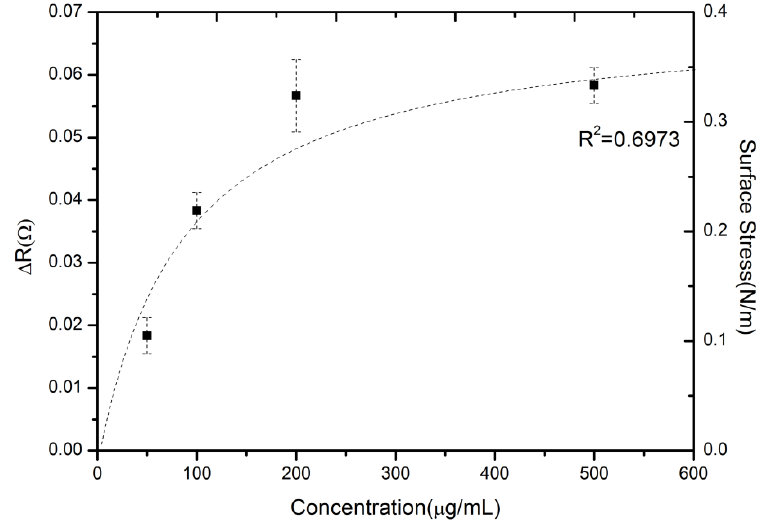
Figure 4. The reproducible, measured steady-state signals of various valproic acid concentrations. The dynamic range and sensitivity were also investigated by varying the valproic acid